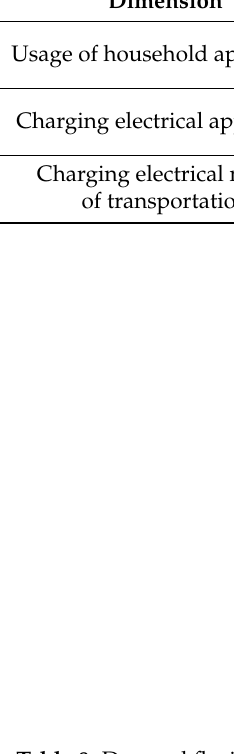
Table 8. Demand flexibility comparisons of Solar-consellers (treated) versus Non-owners (controls) (source: authors’